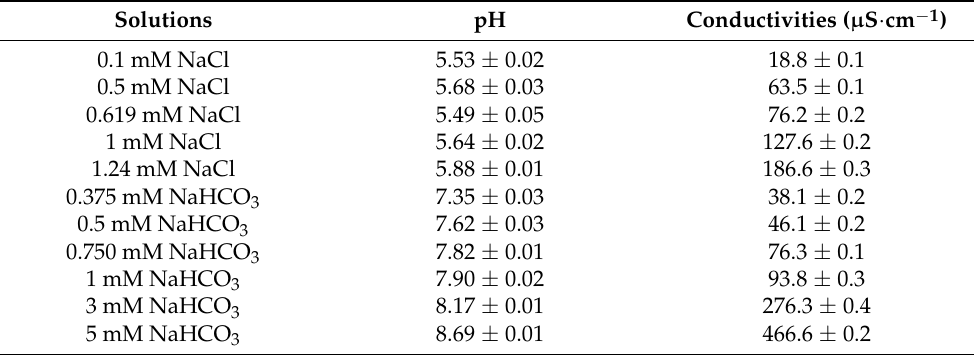
Table 2. Measured pH values and conductivities for